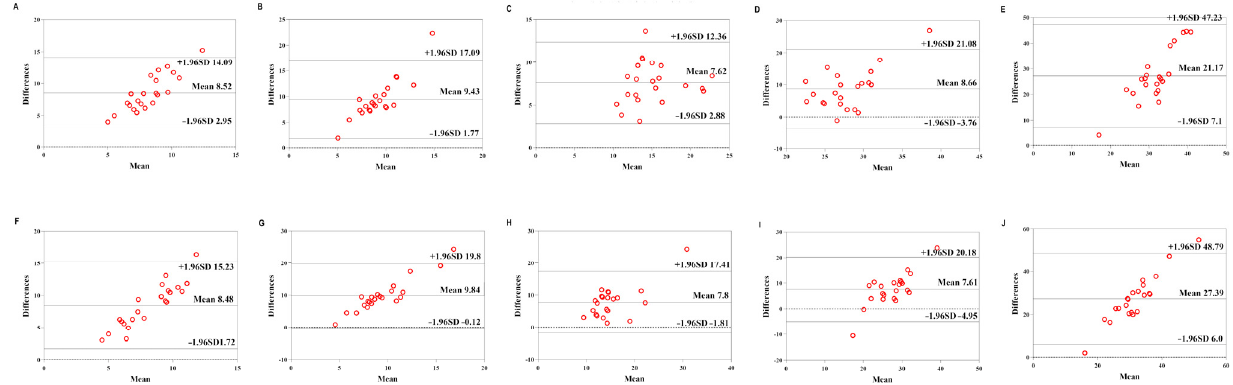
Figure 6. Comparison between the Lexin Mio smart bracelet (Mio) and gas-analysis system (GAS) for energy expenditure (EE) in the low-physical-activity level (LPAL) group. ( A ) Bland–Altman plots of mean of left Mio and GAS for EE under rest condition. ( B ) Bland–Altman plots of mean of left Mio and GAS for EE under the low-intensity exercise. ( C ) Bland–Altman plots of mean of left Mio and GAS for EE under the middle-intensity exercise. ( D ) Bland–Altman plots of mean of left Mio and GAS for EE under the high-intensity exercise. ( E ) Bland–Altman plots of mean of left Mio and GAS for EE under recovery condition. ( F ) Bland–Altman plots of mean of right Mio and GAS for EE under rest condition. ( G ) Bland–Altman plots of mean of right Mio and GAS for EE under the low-intensity exercise. ( H ) Bland–Altman plots of mean of right Mio and GAS for EE under the middle-intensity exercise. ( I ) Bland–Altman plots of mean of right Mio and GAS for EE under the high-intensity exercise. ( J ) Bland–Altman plots of mean of right Mio and GAS for EE under recovery condition.